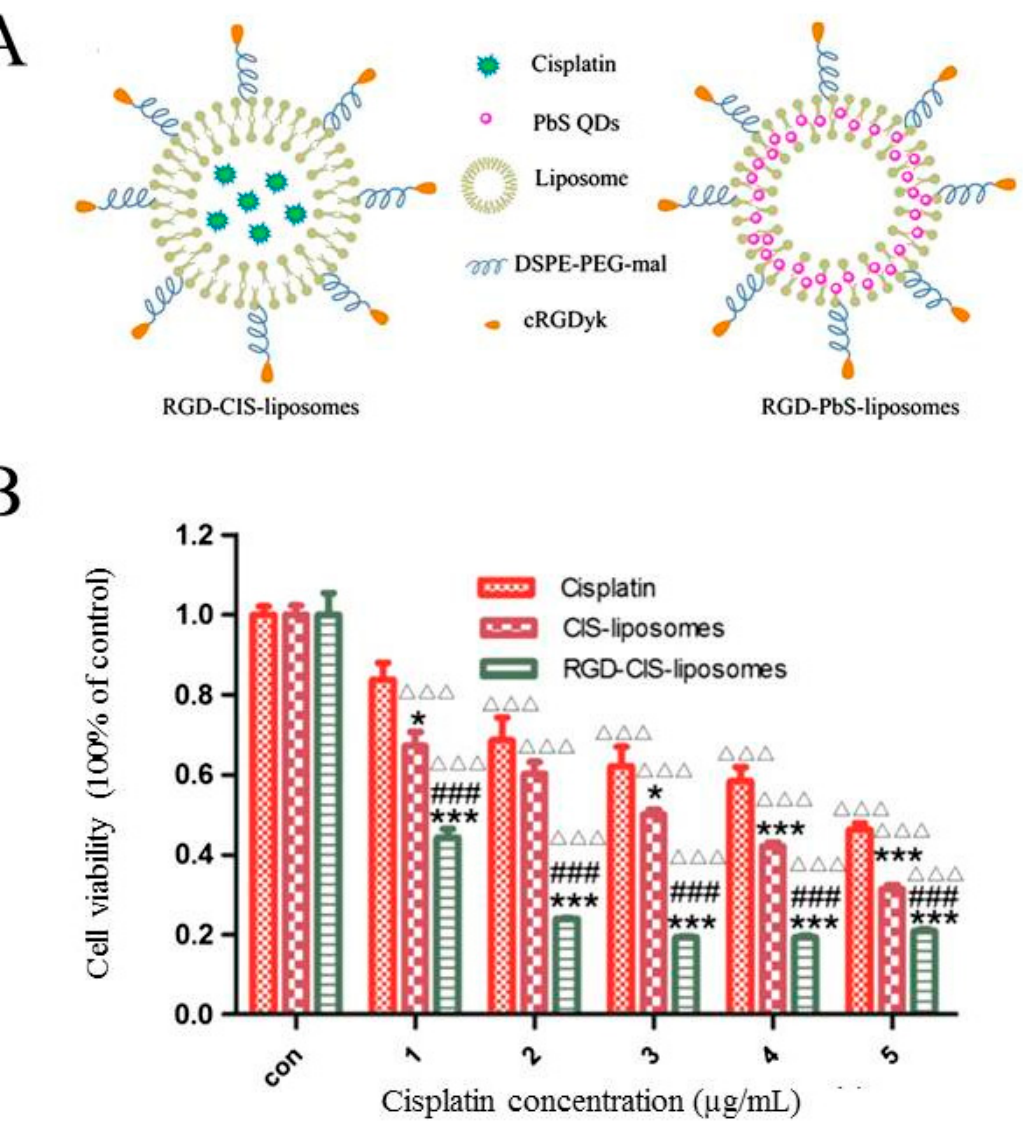
Figure 6. Multifunctional liposomes. ( A ) Schematic diagram of cisplatin (RGD-CIS) and Pbs (RGD-PbS) liposomes. cRGDyk is the integrin ligand. DSPE-PER-mal is 1,2-distearoyl-sn-glycerol-3-phosphotehanolamine- N -[maleimide(polyethylene glycol)-2000]; and ( B ) In vitro cytotoxicity (MTT-assay, RM-1 cells) after 48 h exposure to cisplatin, CIS-liposomes, and RGD-CIS-liposomes. * p < 0.05, *** p < 0.001 versus cisplatin; ### p < 0.001 versus CIS-liposomes; △△△ p < 0.001 versus control. Reproduced with permission from [77].